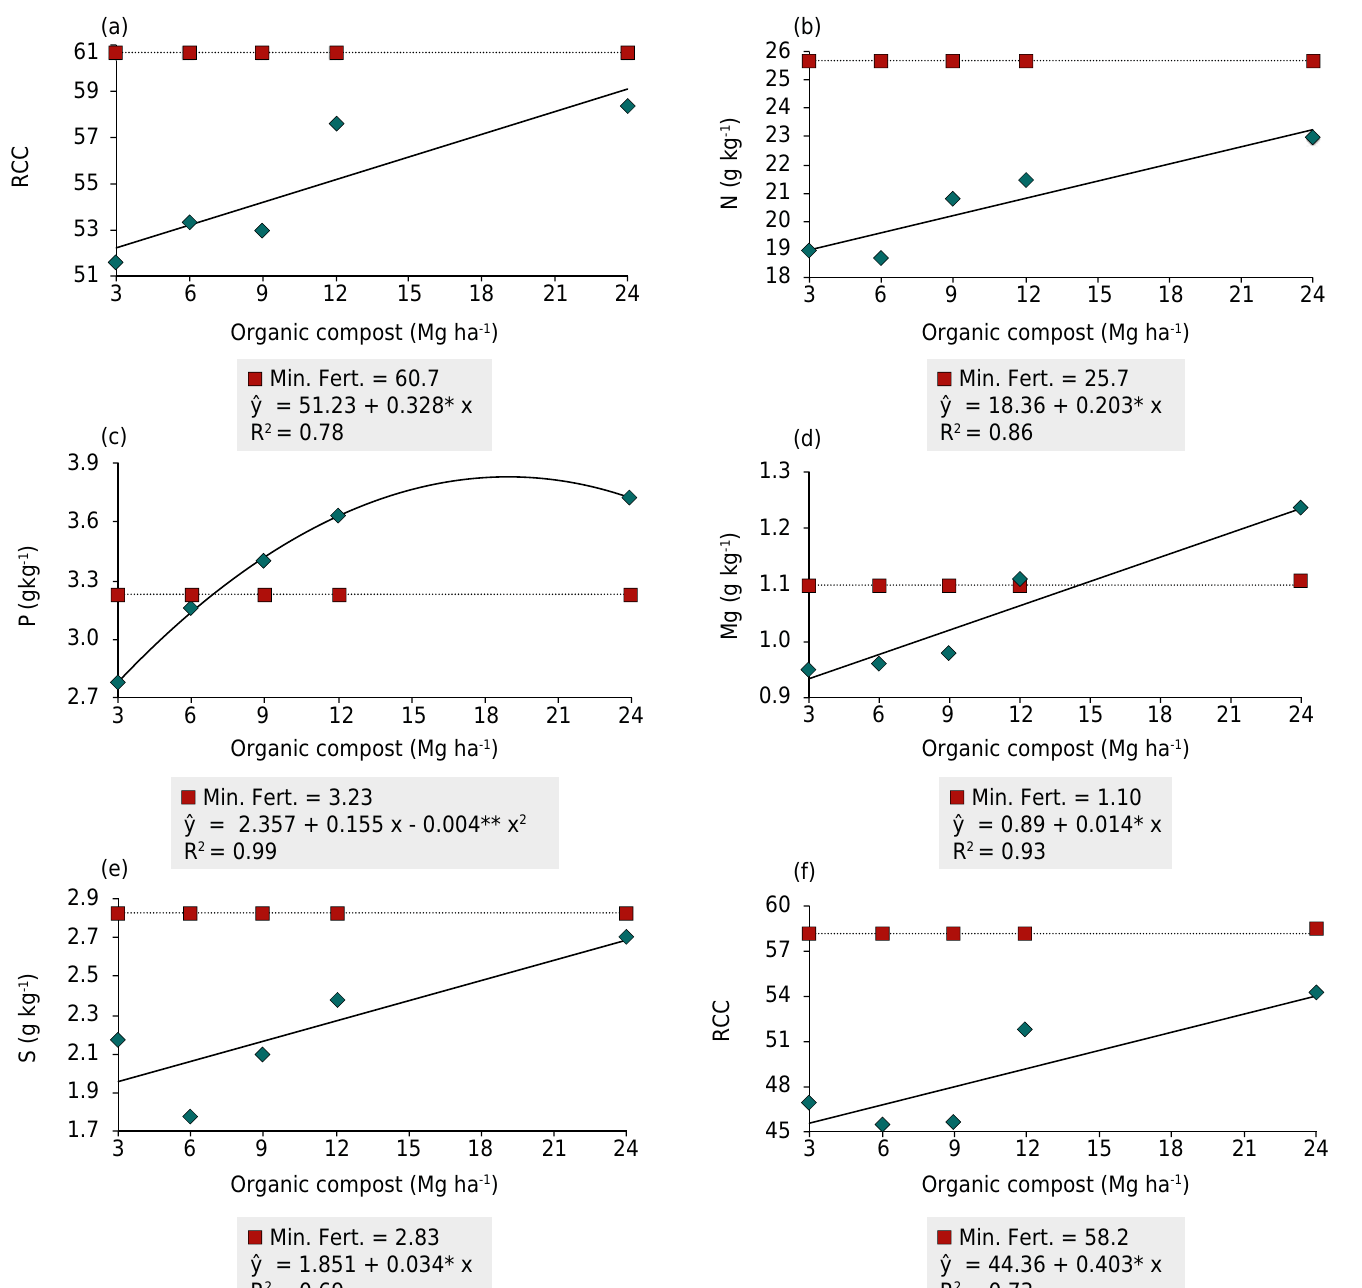
Figure 4. Relative chlorophyll concentration (a) in the 2013 crop; concentration of nitrogen (b), phosphorus (c), magnesium (d), sulfur (e) and relative chlorophyll concentration (f) in the 2014 crop in function of organic compost doses. * and ** : significant at 5 and 1 % probability, respectively. Min. Fert.: Mineral